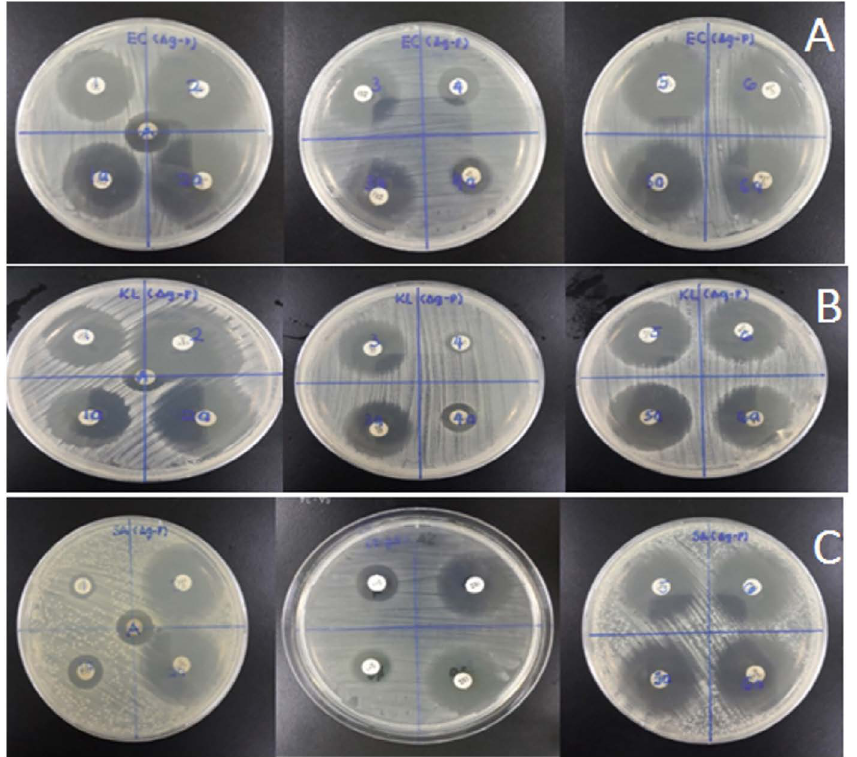
Fig 4. Zone of inhibition comparison between antibiotic with and without AgNPs samples (a) E.coli (b) Klebsiella pneumonia (c) Staphylococcus